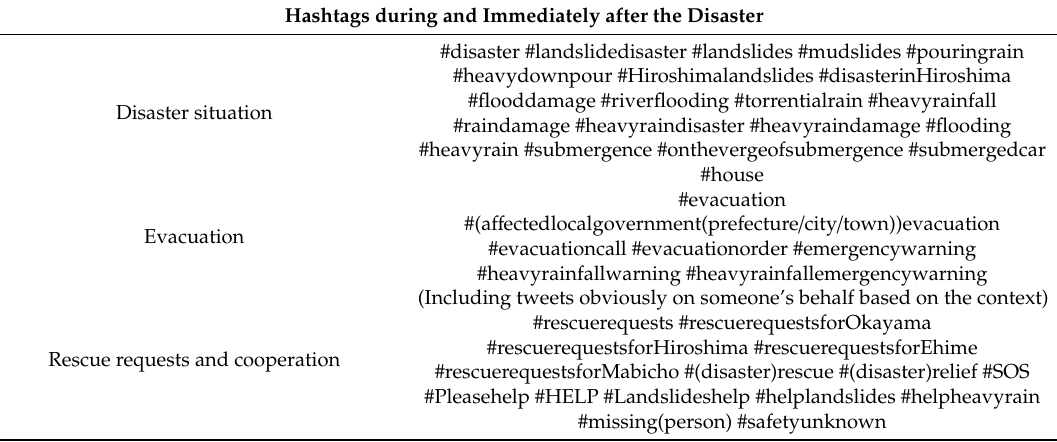
Table 1. Utilization of hashtags in tweets related to the heavy-rain disaster in Western Japan in 2018. Hashtags during and Immediately after the